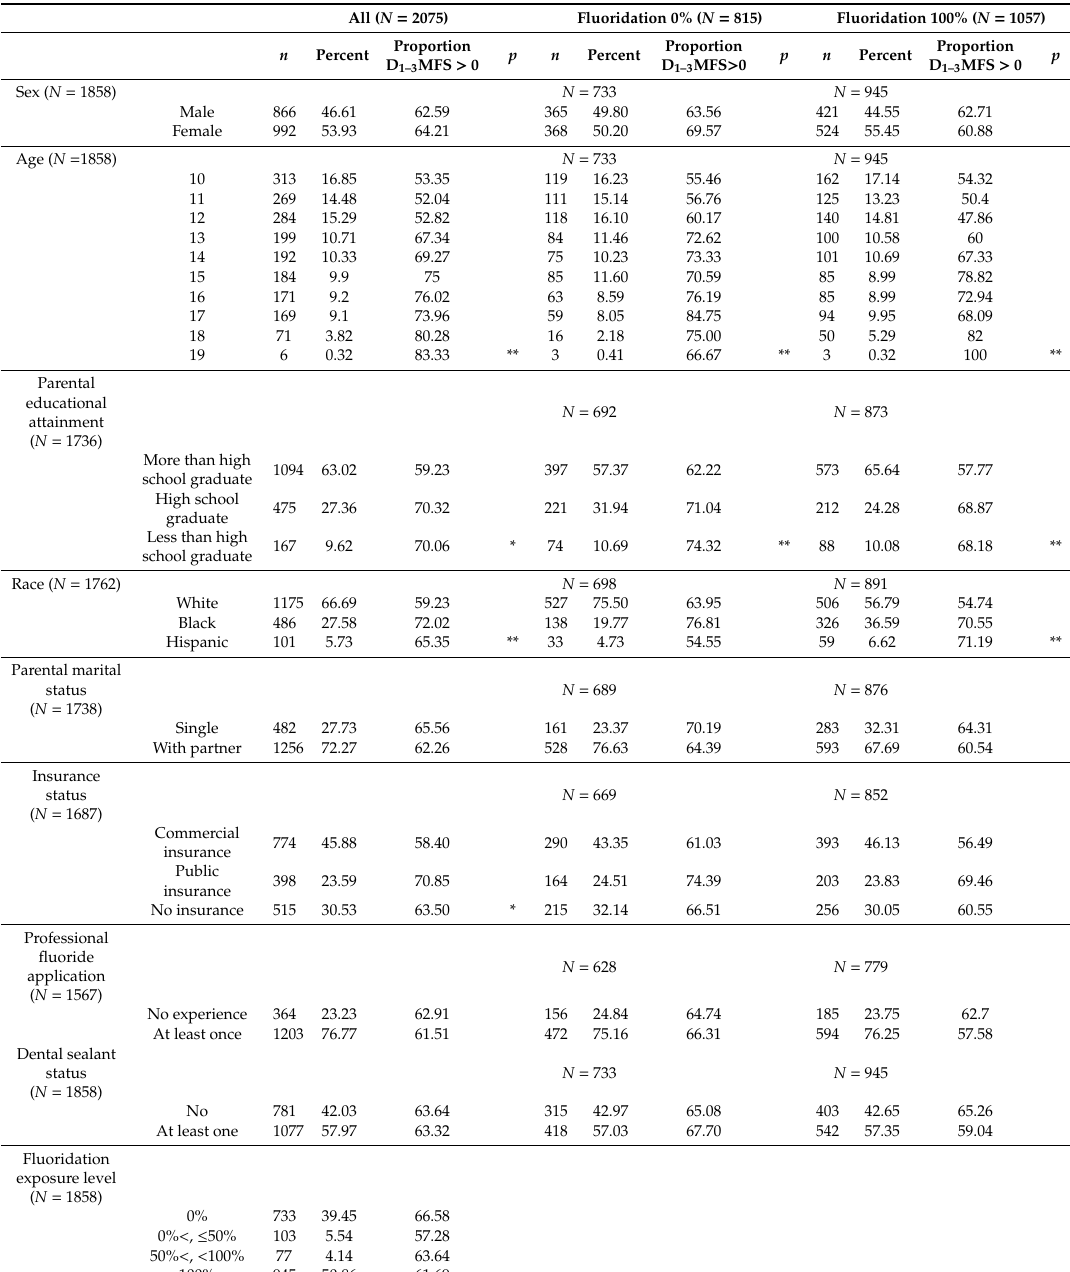
Table 1. Basic characteristics of the study